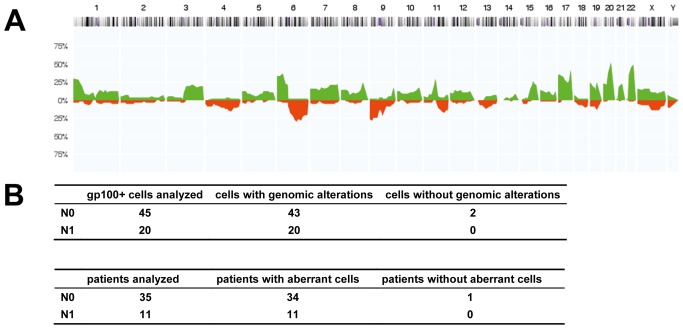
Chromosomal aberrations of isolated gp100-positive cells.(A) CGH profiles of gp100-positive cells (n = 57 cells, all displaying chromosomal aberrations in metaphase CGH). The histogram displays the percentage of cells with specific chromosomal alterations. The chromosomal position is indicated by the horizontal chromosome ideogram (from Chromosome 1 on the left to the X and Y chromosomes on the right). Copy number gains for each region are depicted in green, and copy number losses are depicted in red. (B) Summary of findings for all 65 cells and 46 patients with respect to the lymph node status as determined by routine histopathology (N0 = histopathologically negative nodes, N1 = histopathologically positive nodes). After analysis of the eight cells with normal karyotypes in metaphase CGH by array CGH, all but two cells displayed genomic aberrations. One of these two cells was isolated from a sample where an additional gp100-positive cell displayed alterations, while the other cell was the only gp100-positive cell detected in that patient.